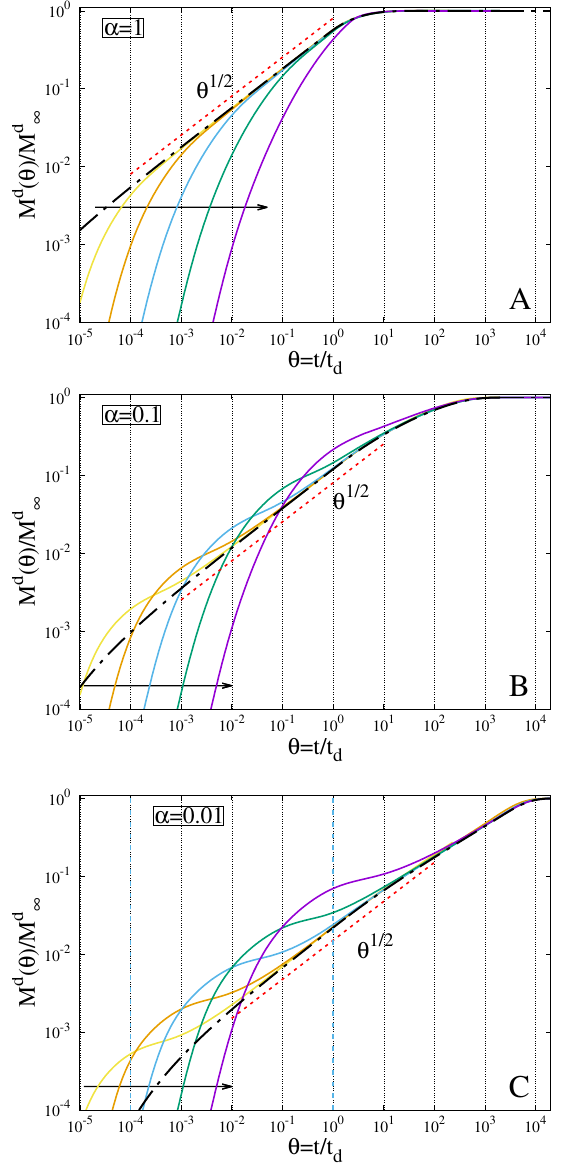
Figure 5. Drug release curves M d ( θ ) / M d ∞ for different values of De and α = D d / D . Arrows indicate increasing values of De = 10 − 4 ,10 − 3 ,10 − 2 ,10 − 1 ,10 0 . Dot-dashed black lines represent the limiting case De → 0. ( A ) α = 1; ( B ) α = 0.1; ( C ) α =